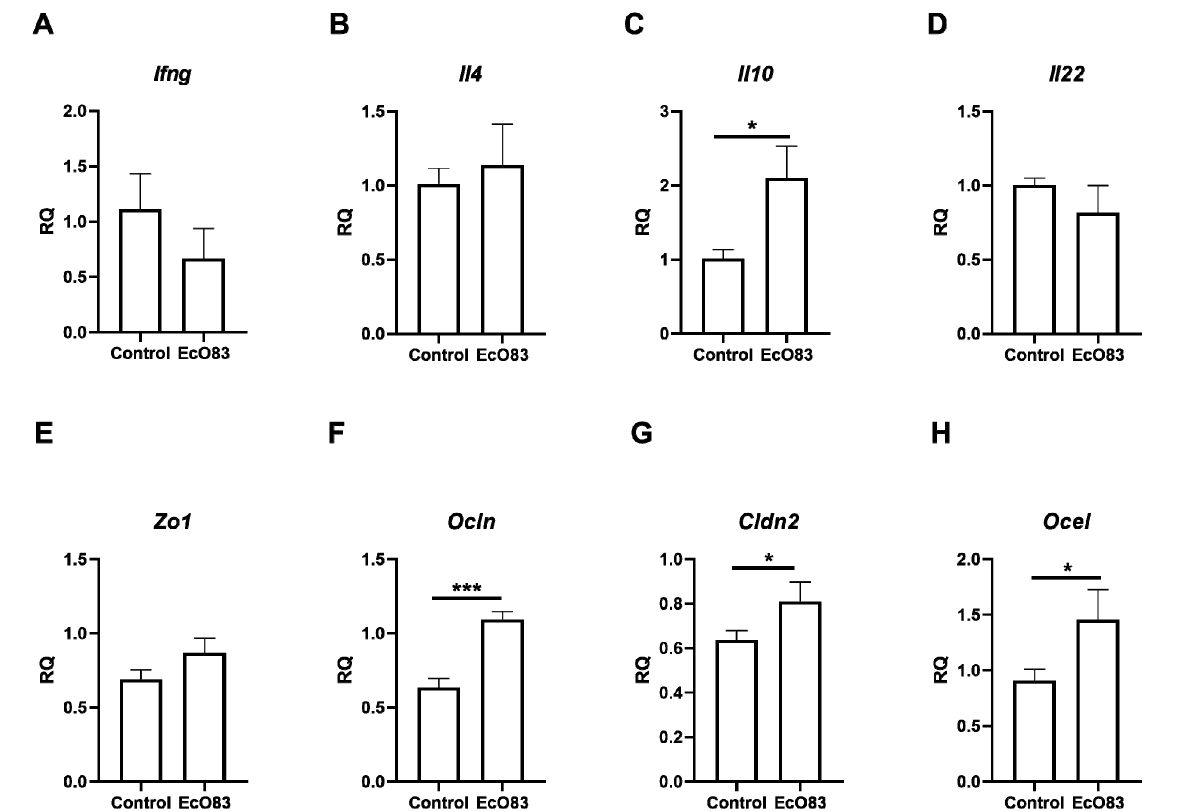
Figure 5. The impact of early postnatal E. coli O83:K24:H31 (EcO83) administration on gene expression of cytokines and tight junction proteins in neonatal gut measured by quantitative real-time PCR at the age of 10 days. ( A )—gene expression of Ifng ; ( B )—gene expression of Il4 ; ( C )—gene expression of Il10 ; ( D )—gene expression of Il22. Gene expression of proteins associated with barrier function: expression of zonulin 1 ( Zo1 )—( E ); expression of occludin ( Ocln )—( F ); expression of claudin 2 ( Cldn2 )—( G ); and expression of occludin/ELL domain containing 1 ( Ocel )—( H ). One representative experiment of three independent experiments is shown. Columns represent mean with standard error mean of 12 mice in total. * p ≤ 0.05, *** p ≤ 0.001.